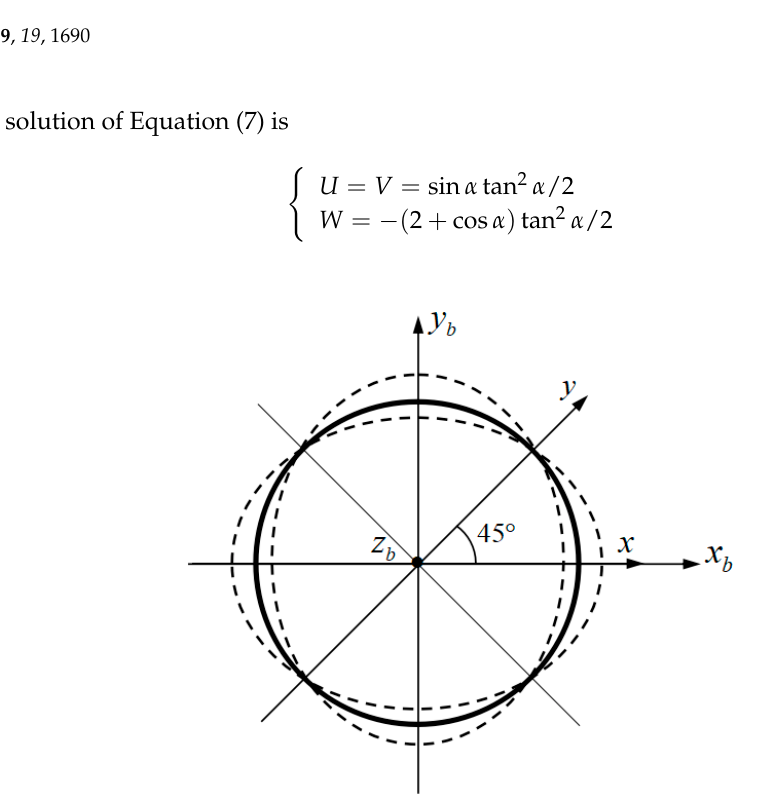
Figure 2. Diagram of second-order vibration mode decomposition.